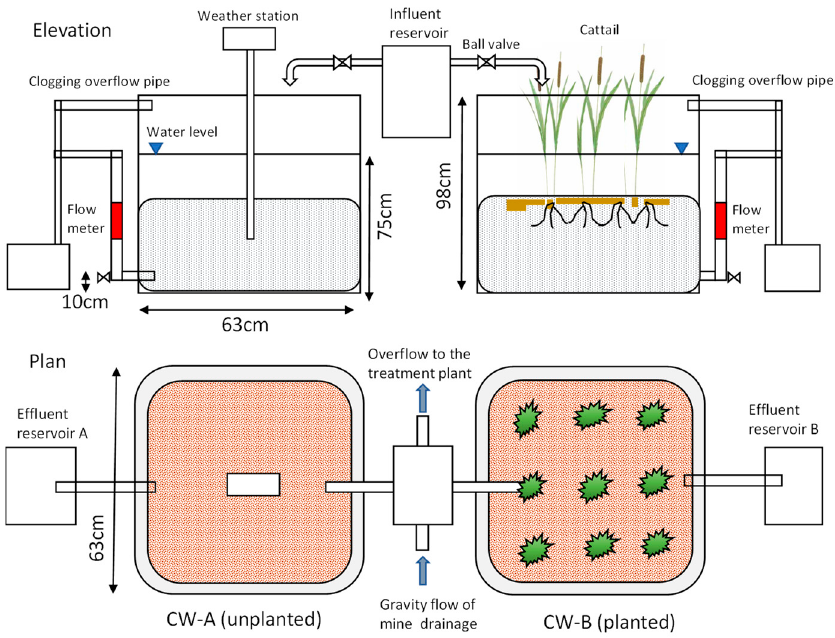
Figure 1. Schematic of pilot-scale CWs: CW-A was unplanted and CW-B was planted with cattails. Water samples were collected from the influent and effluent reservoir tanks.